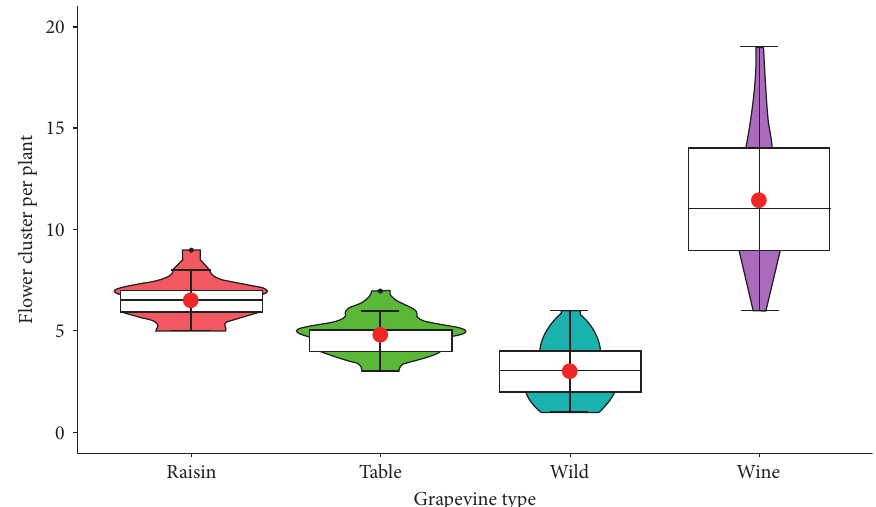
Figure 10: Response of flower cluster number to grapevine types.